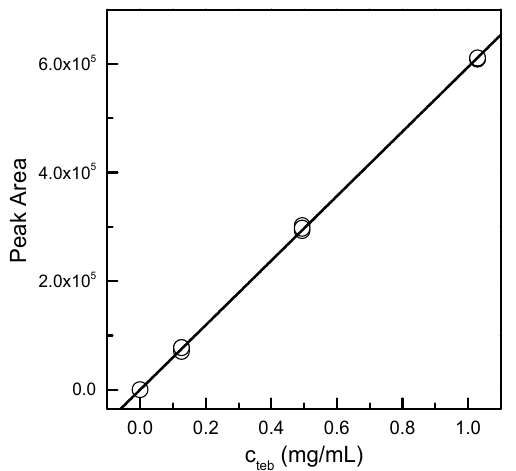
Figure 5. Calibration curve obtained from measurements of tebucanozale solutions in dichloromethane.